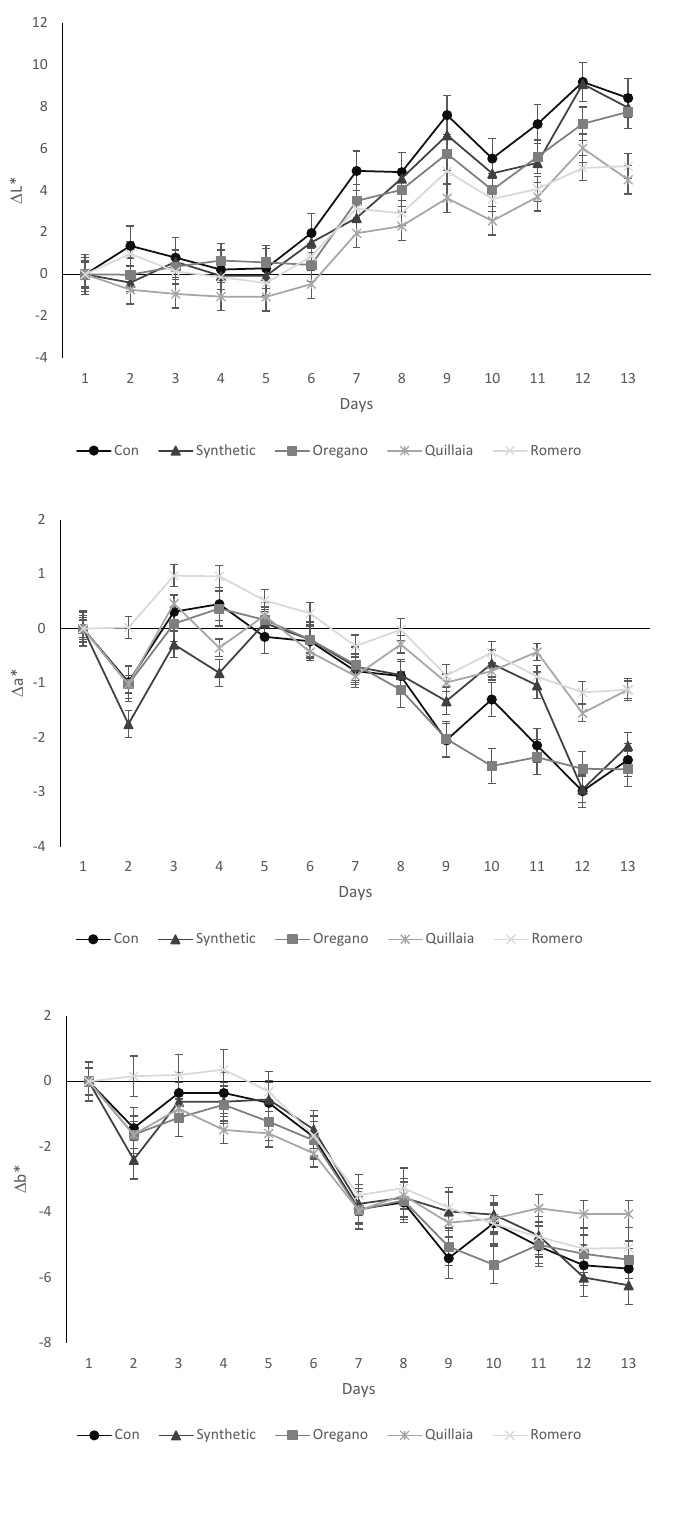
Fig. 1b. Variation of redness (a*) among 12 days of refrigeration at 4 °C